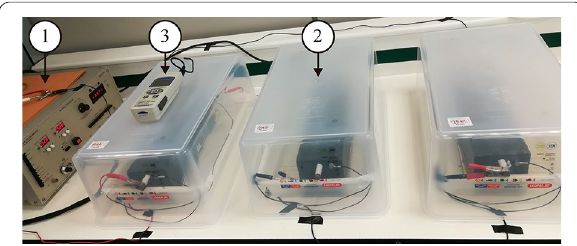
Fig. 3 Setup of the accelerated corrosion test. 1: potentiostat– galvanostat. 2: mortar specimen under test (the specimen is located on a tray with a plastic cover to keep a practically constant relative humidity environment, see text in Sect. 2.2). 3: relative humidity measurement